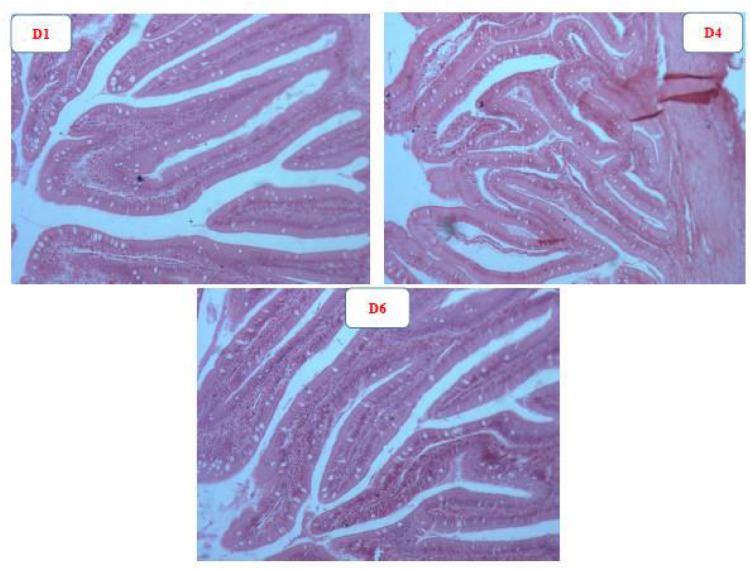
Representative intestinal structure of golden pompano fed D1, D4, and D6 diets.